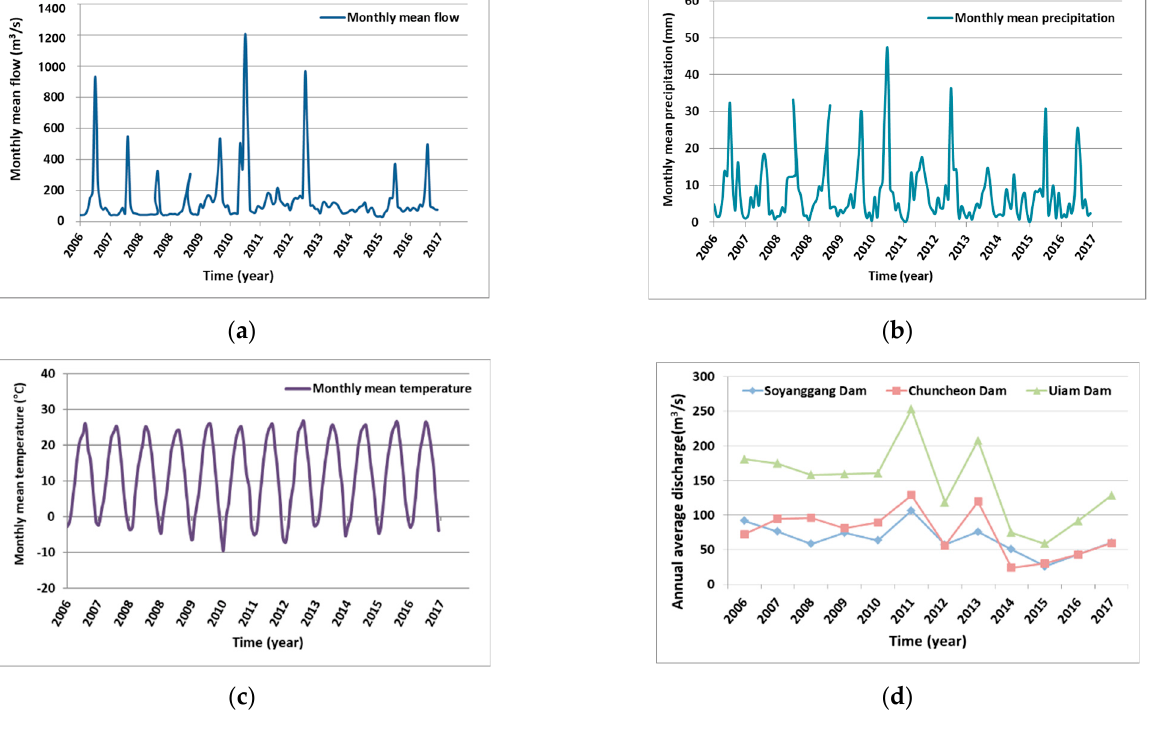
Figure 3. Monthly average temperature, precipitation, and flow in the target area (2006–2017). (( a ) Monthly mean flow (m 3 /s); ( b ) Monthly mean precipitation (mm); ( c ) Monthly mean temperature (°C); ( d ) Annual mean discharge (m 3 /s) (dams)).